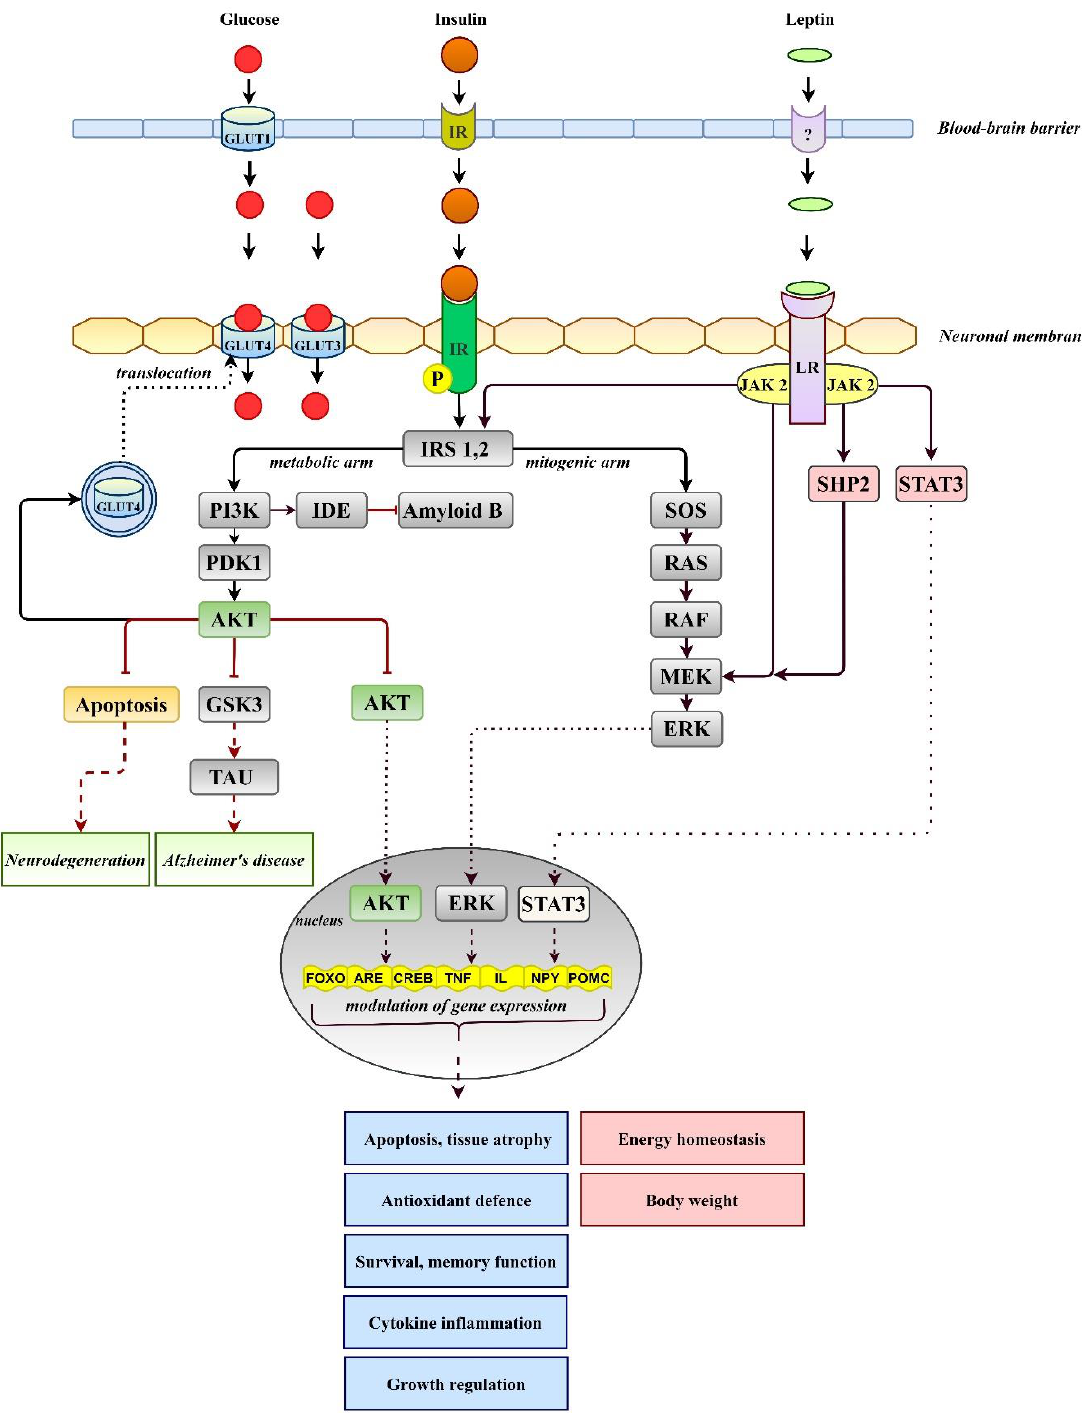
Figure 2. Simplified overview of insulin and leptin signaling. Insulin triggers activation of AKT in the metabolic arm, which modulates antioxidant defense, memory function, and growth- or cytokine-induced inflammation. Leptin after binding to its receptor (LR, long isoform) activates gene expression via phosphoinositol 3 kinase (PI3K), an activator of transcription (STAT3), and extracellular signal-regulated kinase (MAPK/ERK) pathways. IR, insulin receptor; IDE, insulin-degrading enzyme; GLUTs, glucose transporters; GSK3, glycogen synthase kinase-3; PDK1, 3-phosphoinositide-dependent protein kinase; SHP2, sulfhydryl-domain containing protein tyrosine phosphatase; TAU, tau protein.